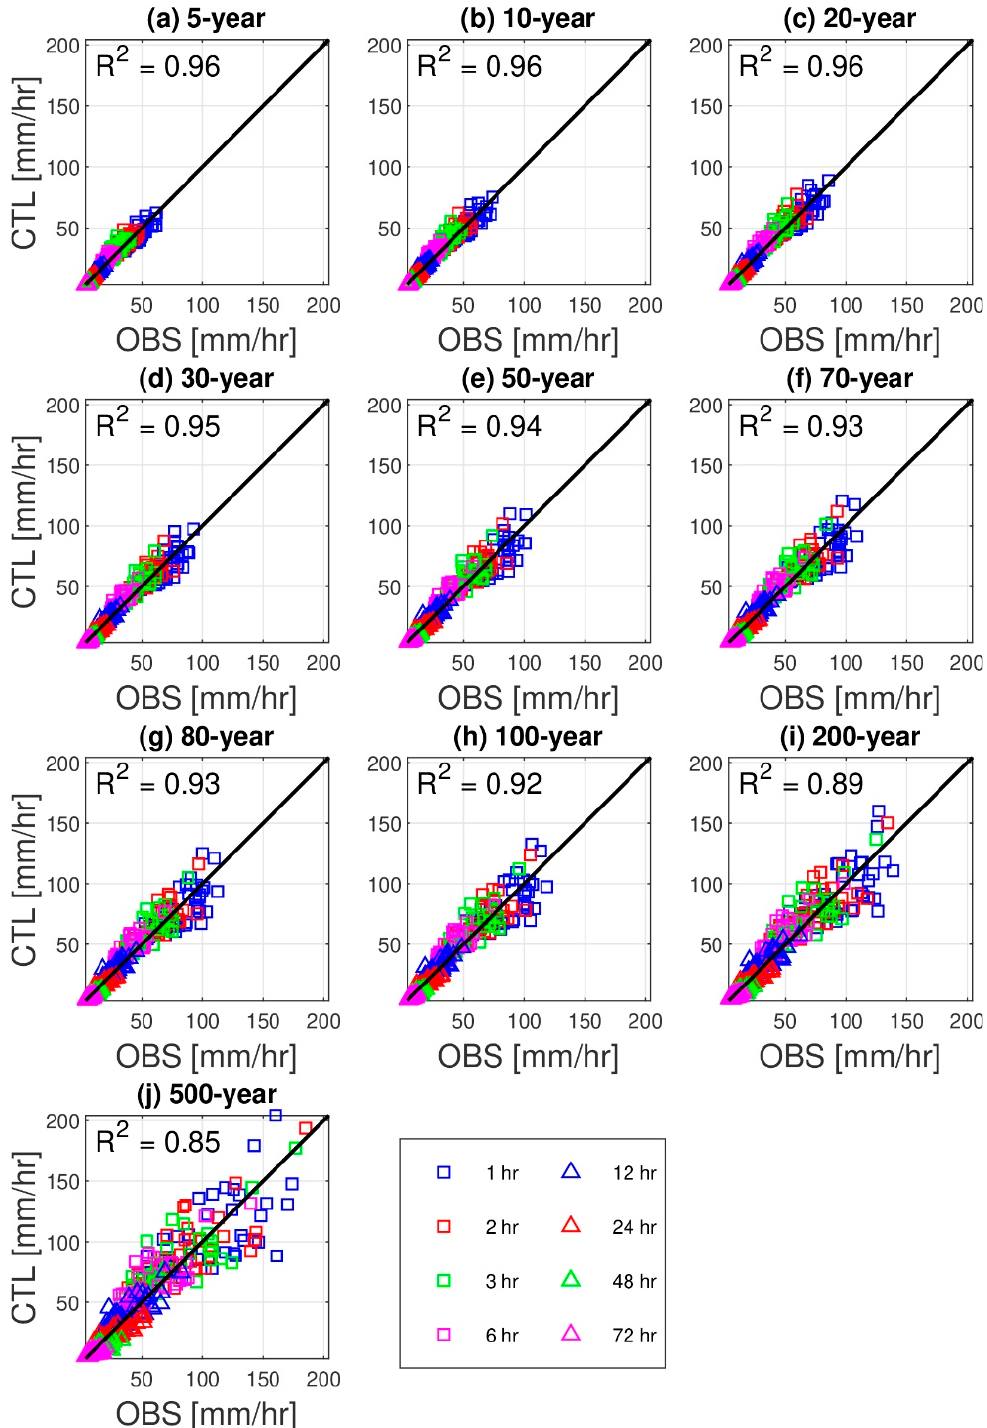
Figure 3. Comparisons of rainfall frequency estimates computed from observation (OBS) from 1981 to 2010 with the values averaged for 100 rainfall frequency estimates (CTL) for 8 durations and 10 return periods. The latter estimates are, respectively, computed from 100 AWE-GEN realizations for the same period. The number of data points in each subplot is 320 (40 locations × 8 durations). Generalized Extreme Value distribution and probability weighted moment method are used for both